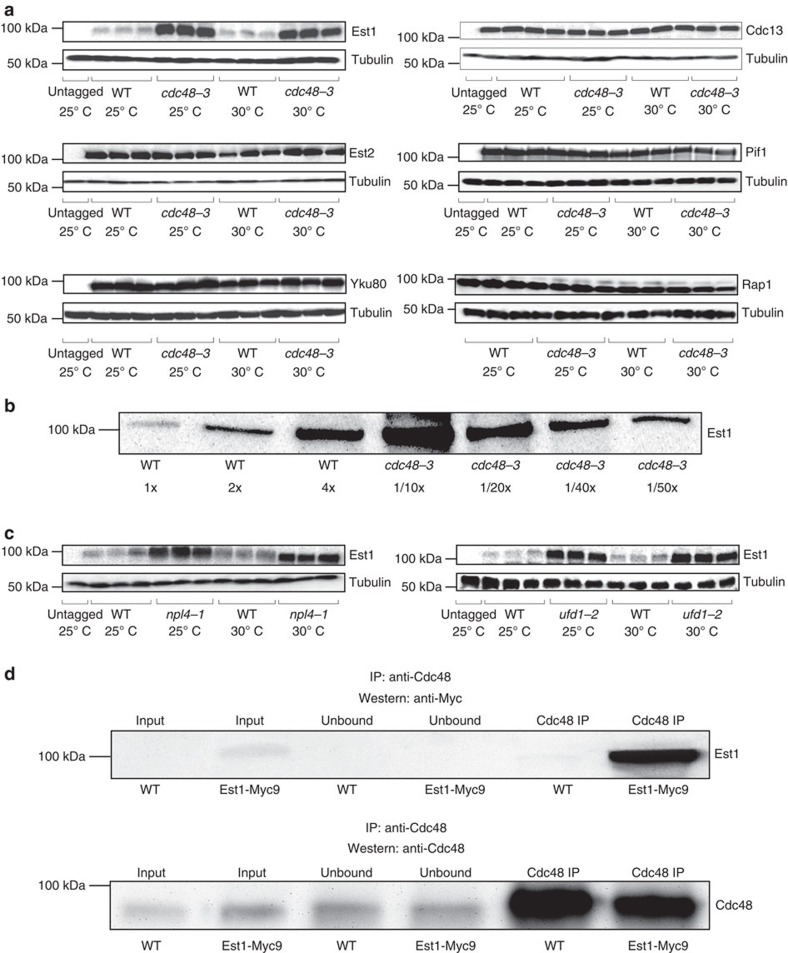
Est1 physically interacts with Cdc48 and its abundance is increased in cdc48-3, npl4-1 and ufd1-2 cells.(a) Proteins were prepared from three independent isolates of asynchronous cdc48-3 cells grown at 25 °C (permissive temperature) and 30 °C (semi-permissive temperature) or from otherwise isogenic control cells and subjected to SDS–PAGE and western blot analysis. Est1, Est2, Cdc13, Yku80 and Pif1 were visualized with mouse anti-Myc antibodies (Clontech); Rap1 was visualized with rabbit anti-Rap1 antisera (Conrad et al.48); α-tubulin was visualized with rat anti-α-tubulin antibodies (Abcam). (b) Quantification of Est1 levels in WT versus cdc48-3 cells. Extracts were diluted as indicated (or not diluted, 1 × ) and subjected to SDS–PAGE and western blot analysis. Est1 was ∼40-fold more abundant in cdc48-3 compared with WT cells. (c) Est1 levels were elevated in both npl4-1 and ufd1-2 cells compared with their WT counterparts. Methods are the same as in a. (d) Extract of proteins from untagged WT cells or WT cells expressing Est1-Myc9 (input) was immunoprecipitated with goat anti-Cdc48 polyclonal antibodies (Abgent) (Cdc48 IP) and the samples analysed by western blotting with anti-Myc antibodies (Clontech). Supernatants recovered before and after immunoprecipitation were used as input and unbound controls, respectively (top panel). The same samples were analysed by western blotting using anti-Cdc48 antibodies (Abgent) (bottom panel). See Supplementary Fig. 4 for full lane view of these data.